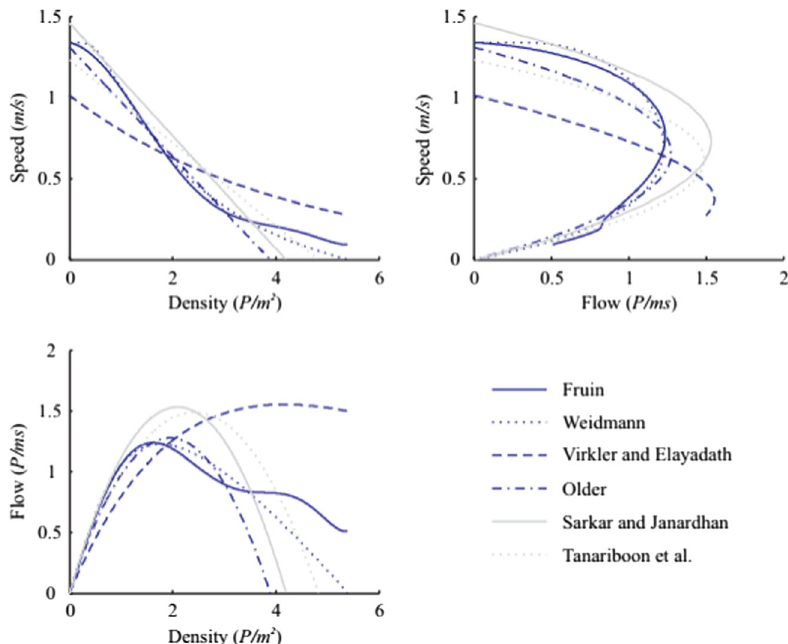
Fig. 1 Fundamental diagrams of pedestrian flow